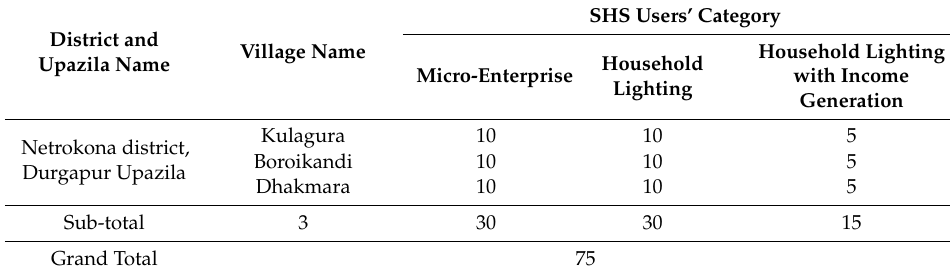
Table 1. Distribution of respondents in the study